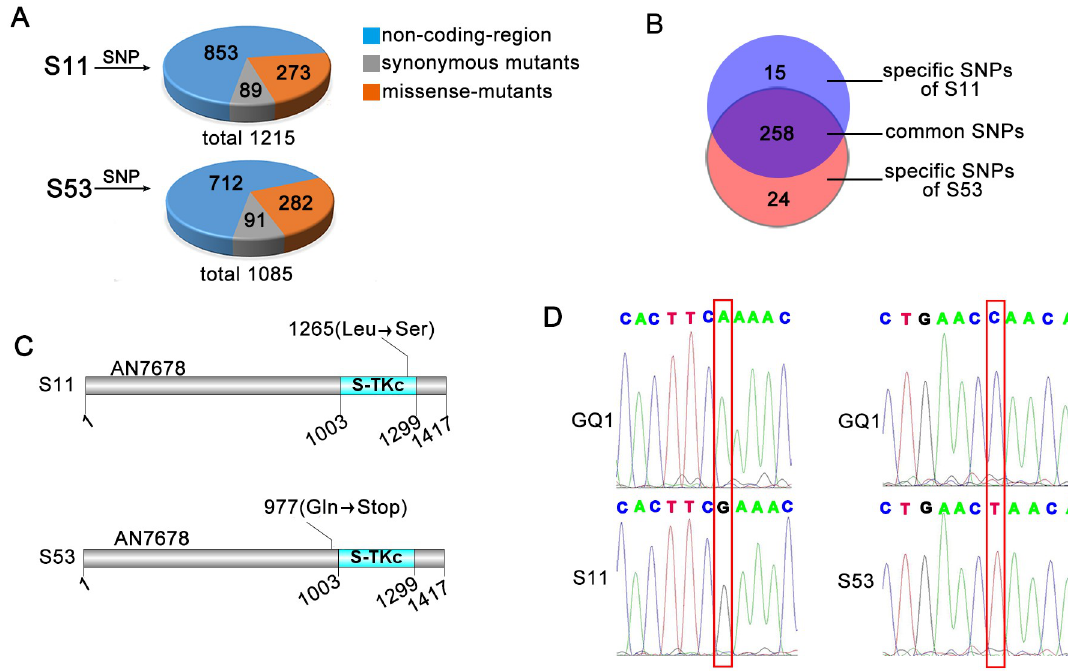
Fig 2. Single nucleotide polymorphism comparison and identification of the pomA mutation in S11 and S53. (A) (B) SNP comparison by next-generation sequencing for the whole genomes of S11 and S53. (C) Domain analysis of PomA with SMART (http:// smart.embl-heidelberg.de/). (D) Mutations in the cloned pomA gene from S11 and S53 identified by